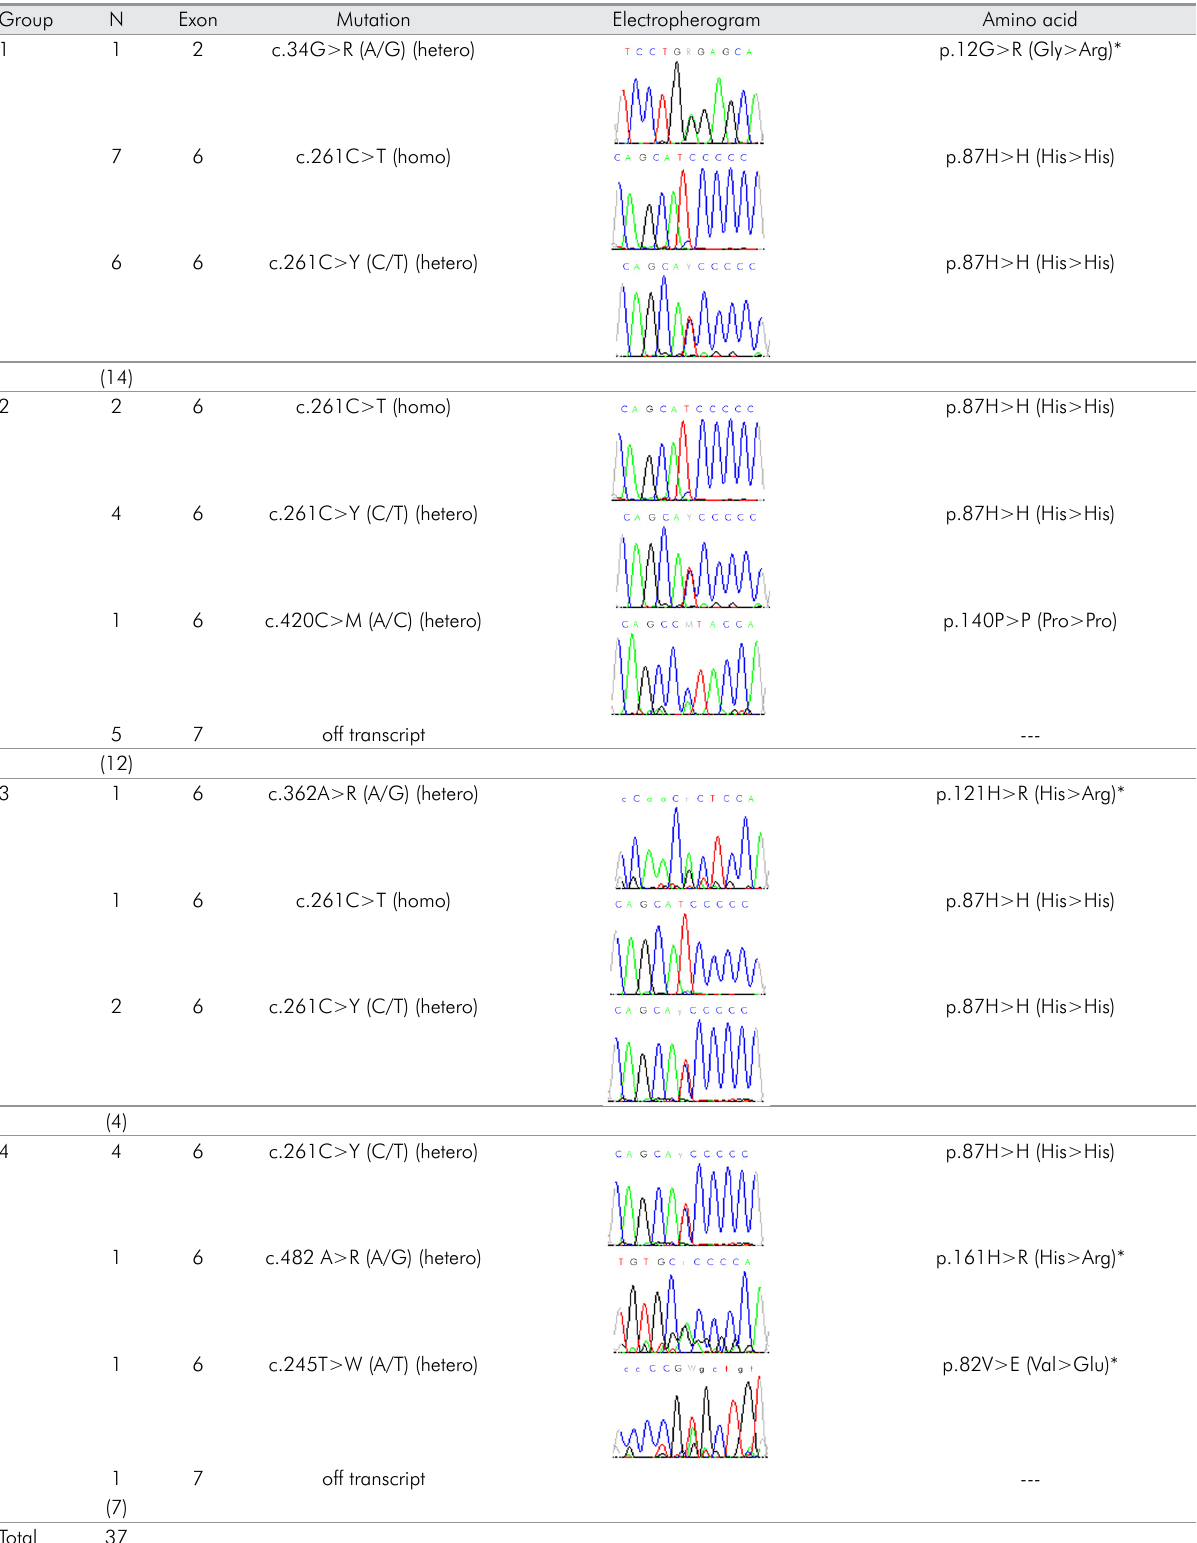
Table 2. Distribution of the mutations found in the four groups studied Group N Exon Mutation Amino